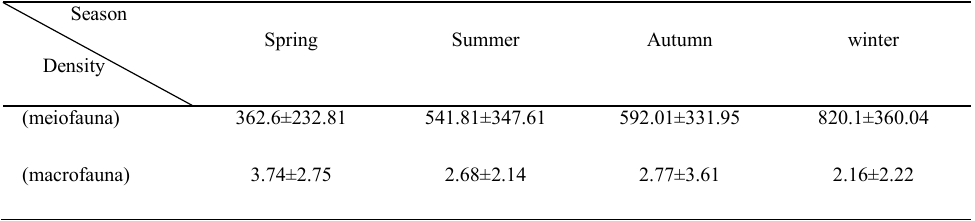
Table 9: Density ofmeiofauna and macrofauna in 10cm 2 of sediment indifferent sesons in the southern Caspian Sea from Behshahr to Ramsar(±SD)